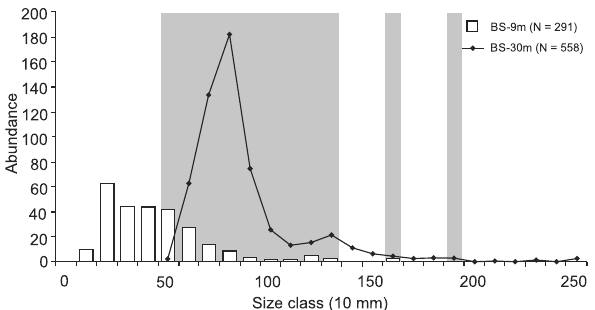
Figure 4. Two beach seine nets relative abundance by size classes of total length (Abundance-TL). Gray area represents the size classes with overlap of nets’